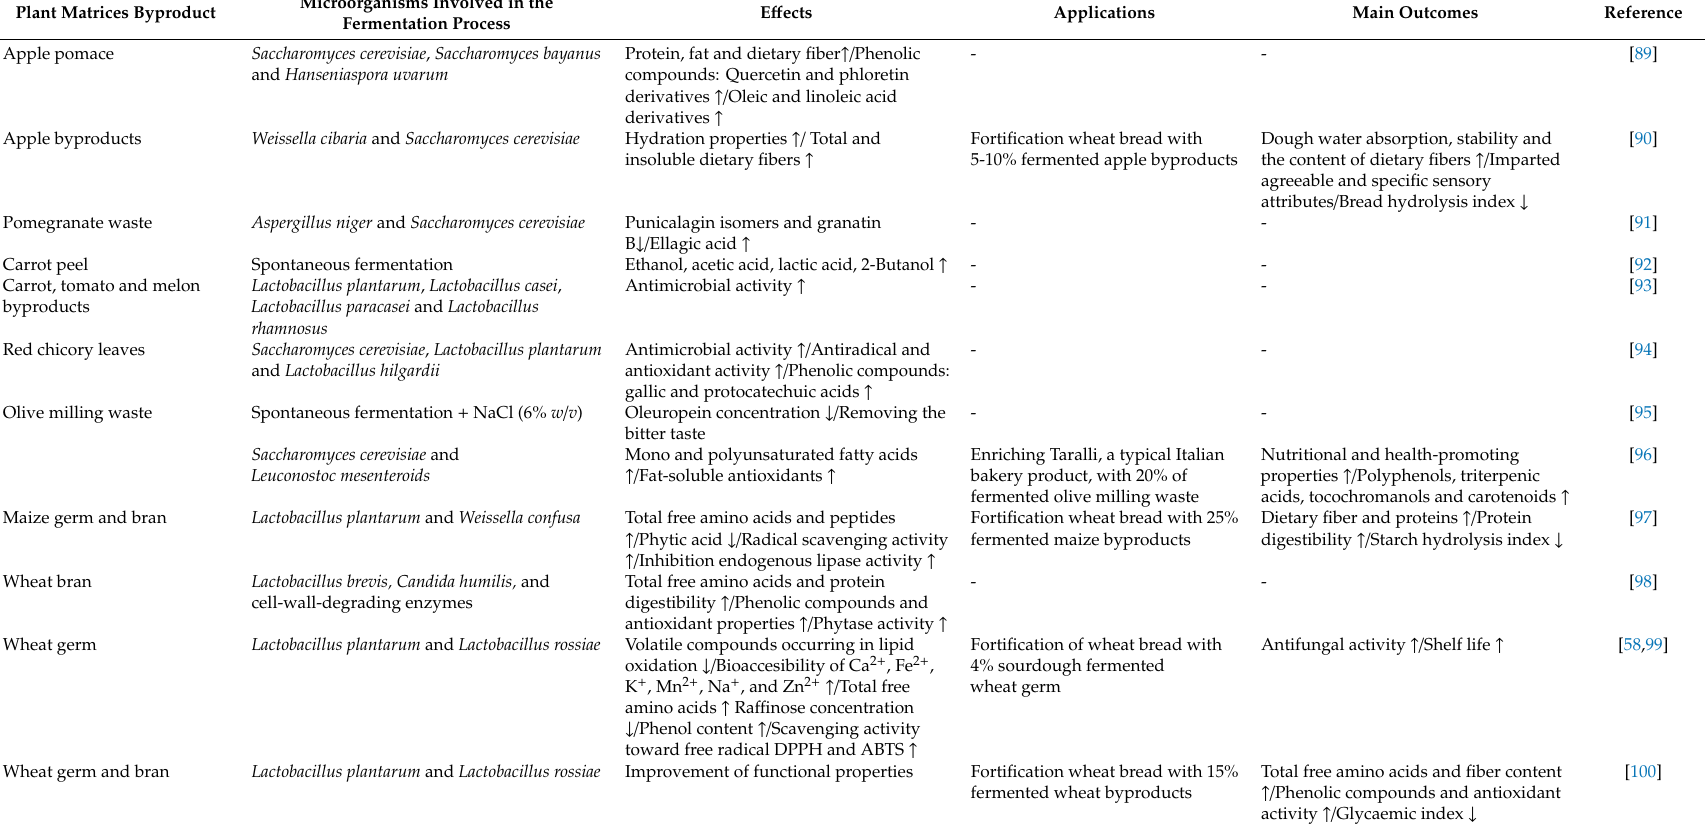
Table 4. Main nutritional and functional e ff ects of fermentation in plant industry byproducts and related